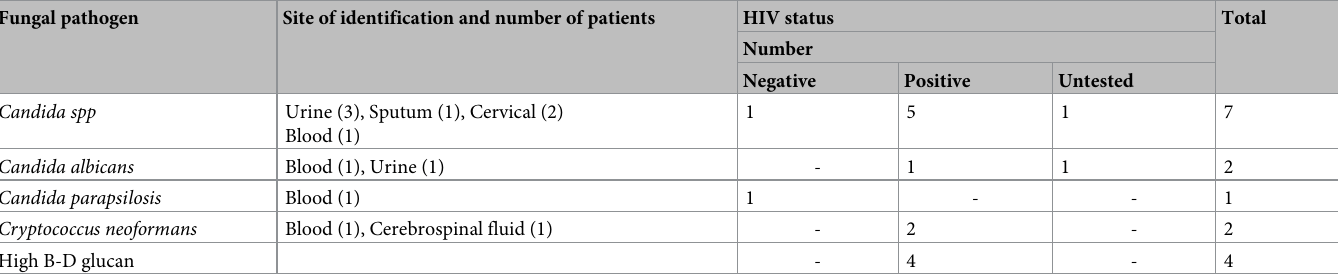
Table 3. Fungal pathogens identified at the time of DIC